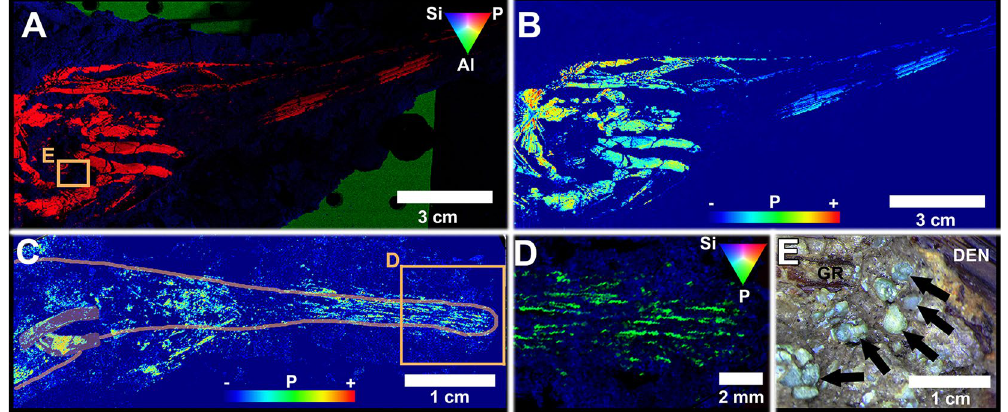
Figure 1. SRS-XRF elemental mapping of two polyodontids from Tanis [Draft image; replace with actual figure in editing phase]. The skull of a yearling fish in lateral view (FAU.DGS.ND.725.32.T) is shown as ( A ) a tricolor plot (red = phosphorus; blue = silicon; green = aluminium) and ( B ) a heat map for phosphorus, showing high definition of well ossified articulated skull elements. The skull of a sub-yearling polyodontid (FAU. DGS.ND.711.14.T) exhibits underdeveloped osseous anatomy characteristic of an earlier ontogenetic stage ( C ), however still possesses well-recognizable rostral elements ( D ). (Tricolor plot in D: green = phosphorus; blue = silicon; red channel muted). ( E ), A magnified view of the skull in ( A , B ) seen under normal light shows multiple impact spherules (arrows) near the gill rakers (GR = gill rakers, DEN =